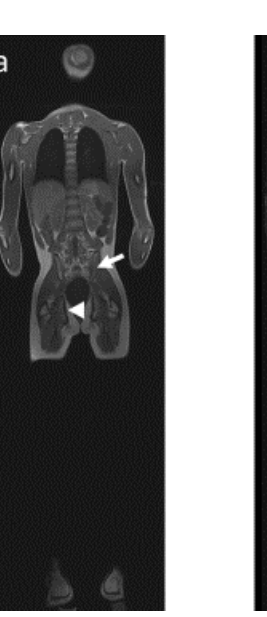
osteolytic with a sclerotic rim, mixed lytic and sclerotic lesions, purely sclerotic lesions, vertebral compression and soft tissue involvement [35].